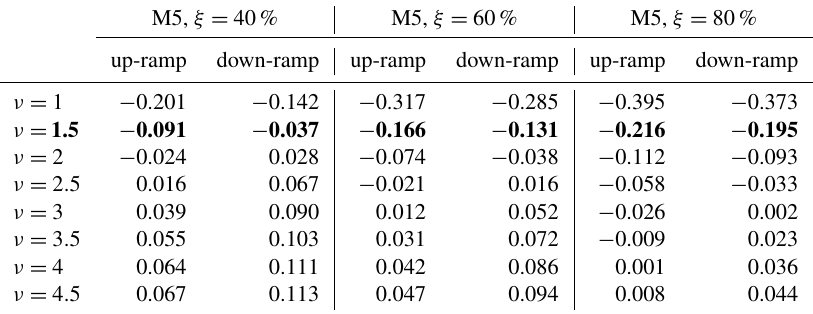
Figure 10. Box plots of BSS of power ramp events identified in 3h time windows from forecast scenarios generated with the StSS (blue), MDSS (pink), MDSS + (green), and GC (brown) methods. BSSs are shown for the PNW tower location ( a , c , and e ) and the M5 tower location ( b , d , f ) and for up-ramps (filled box plots) and down-ramps (non-filled box plots). Ramp events with a power threshold of ξ = 20% ( a and b ), 40% ( c and d ), and 60% ( e and f ) change in the turbine power capacity are shown. The box plots display the interquartile range (rectangle region), the median (middle line within rectangle), outliers (dots), and values outside the interquartile range but not considered outliers (lower and upper whisker) of the distributions. Outliers are values more than 1.5 times the interquartile range. For reference, a line (gray dashed) showing zero skill is plotted. Table 2. Average BSSs from 1000 GC scenarios of 6h up- and down-ramp events at the M5 tower location as a function of range parameter ν and power threshold ξ . The bold values represents the ν value that best matched the empirical covariance values obtained for the M5 tower (see Fig. A1). M5, ξ = 40% M5, ξ = 60% M5, ξ =